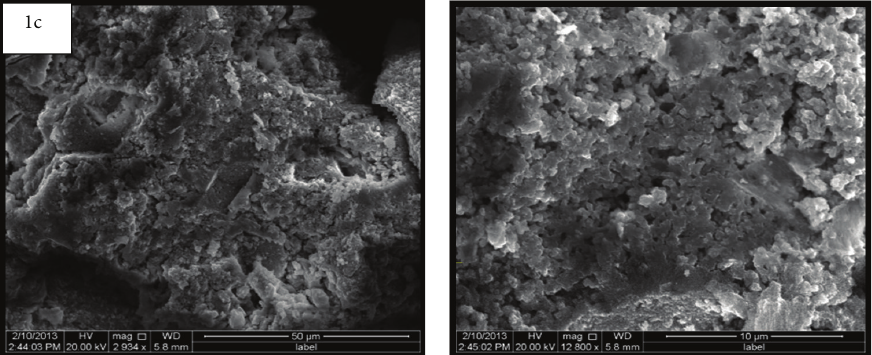
Figure 10: SEM of 1c